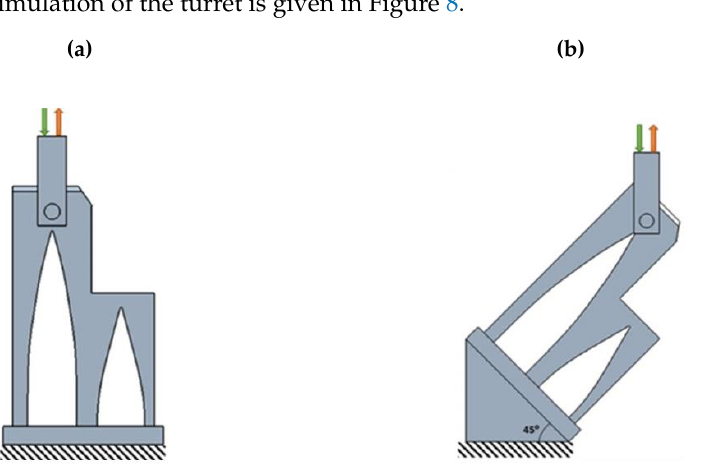
Figure 8. Configuration of the turret, where the tensile and compression loads were applied at ( a ) 0° and ( b ) 45°.